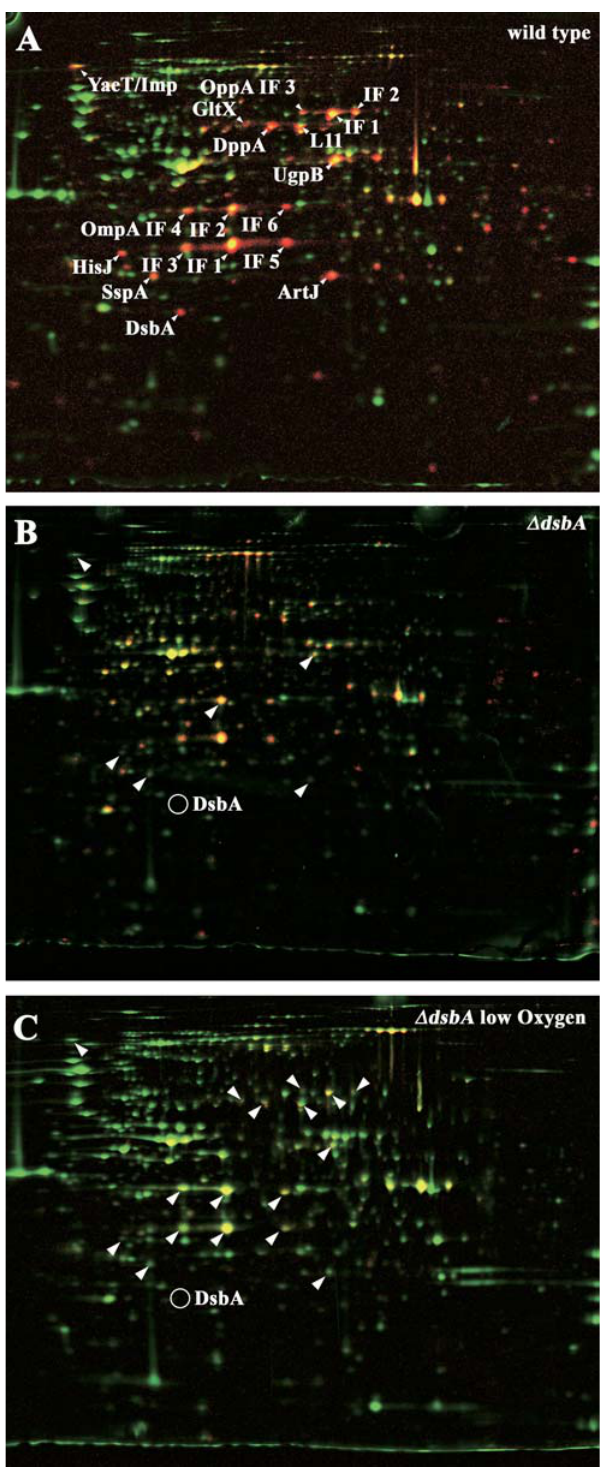
Figure 3. Identification of In Vivo Substrate Proteins of the Periplasmic Disulfide Bond Oxidase DsbA (A) Colored overlay of the stained 2D gel (shown in green) and the phosphor image (shown in red) of differentially trapped protein extract from exponentially growing E. coli wild-type cells. Proteins with a high 14 C activity/protein ratio appear red, while proteins with a low ratio appear green. Proteins that were found to have significantly lower ratio of 14 C activity/protein in the dsbA ::kan strain (B and C) are